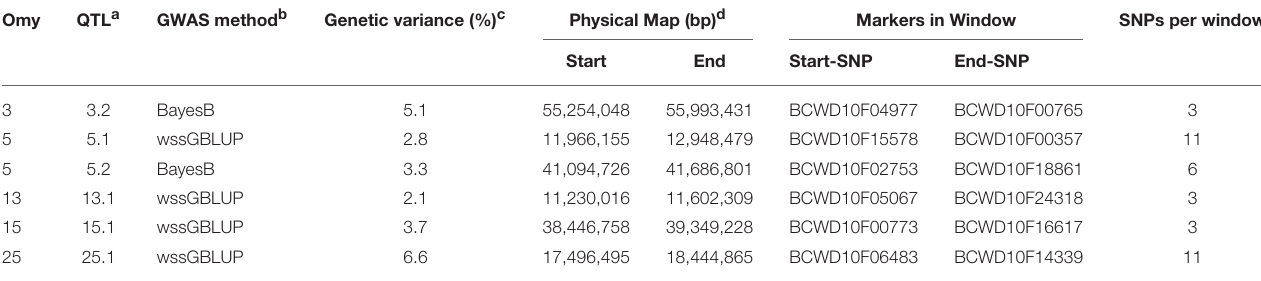
a From each QTL, the window with the highest explained genetic variance is presented in this Table. The QTL nomenclature was based on chromosome number and physical genome map positions of the SNPs that flanked each QTL region within the chromosome, where the region with the lowest position numbers determined to be QTL1, the next QTL2 and so on